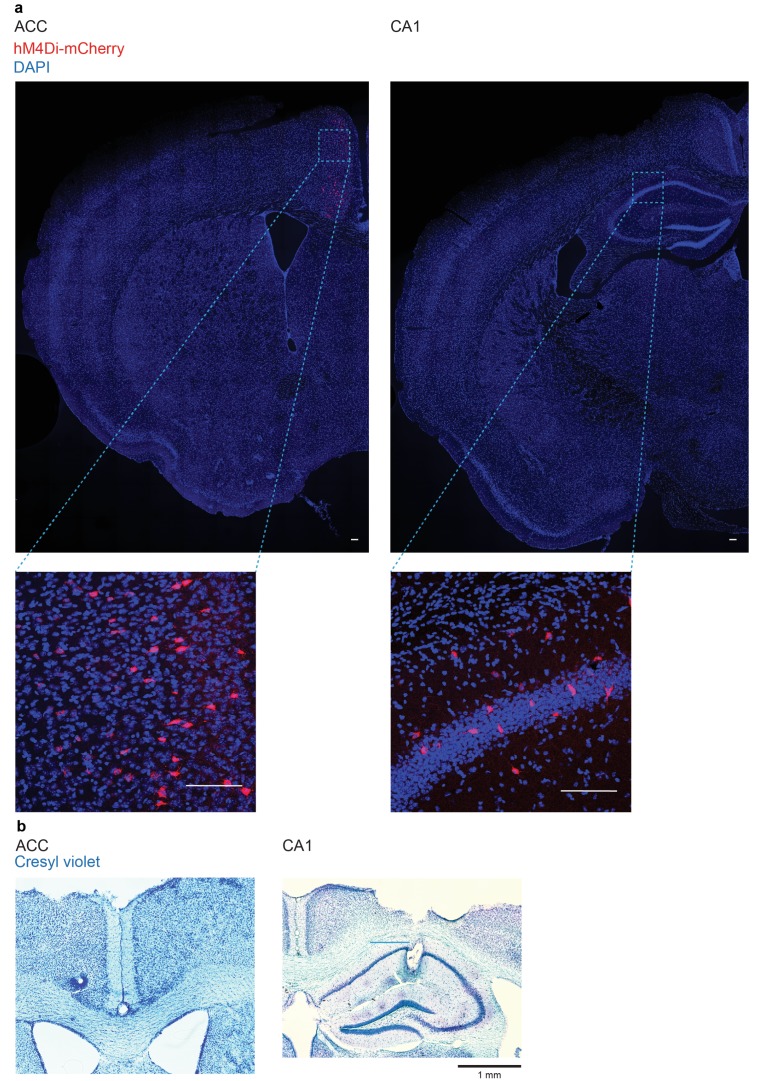
Representative hM4Di-mCherry expression and LFP electrode locations in PV-Cre mice.(a) hM4Di-mCherry expression in PV-Cre mice micro-infused with AAV8-hSyn-DIO-hM4Di-mCherry in ACC (left) or dorsal CA1 (right) (scale bar = 100 μm), and (b) cresyl-violet stained sections from one mouse showing electrode placements in the ACC (left) and dorsal CA1 (right).